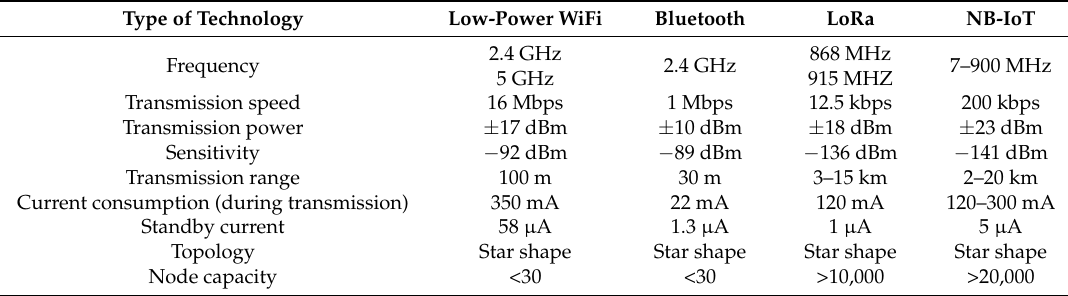
Table 2. Comparison of the technical specifications of different low-power wireless communication systems.